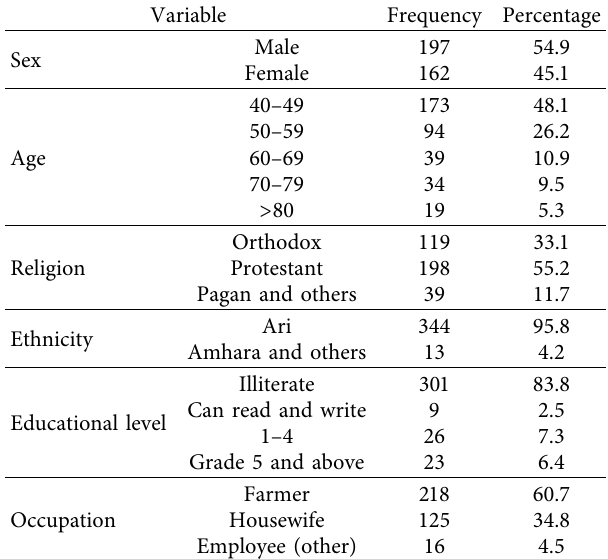
Table 2: Sociodemographic characteristics of participants in South Ari district, Southern Ethiopia, in December 2021 ( n �